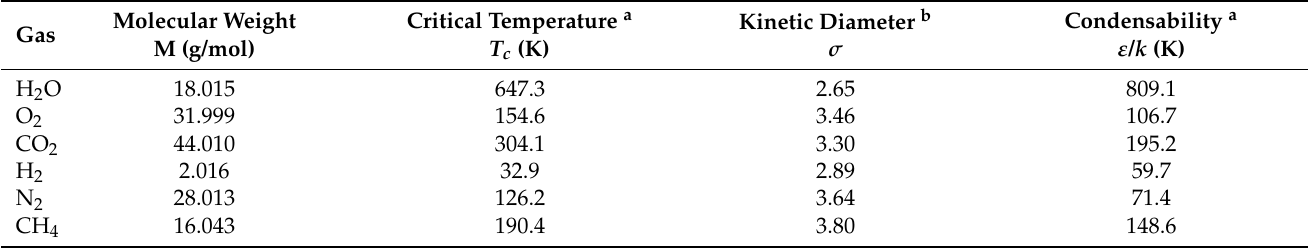
Table 4. Physical properties of water and common